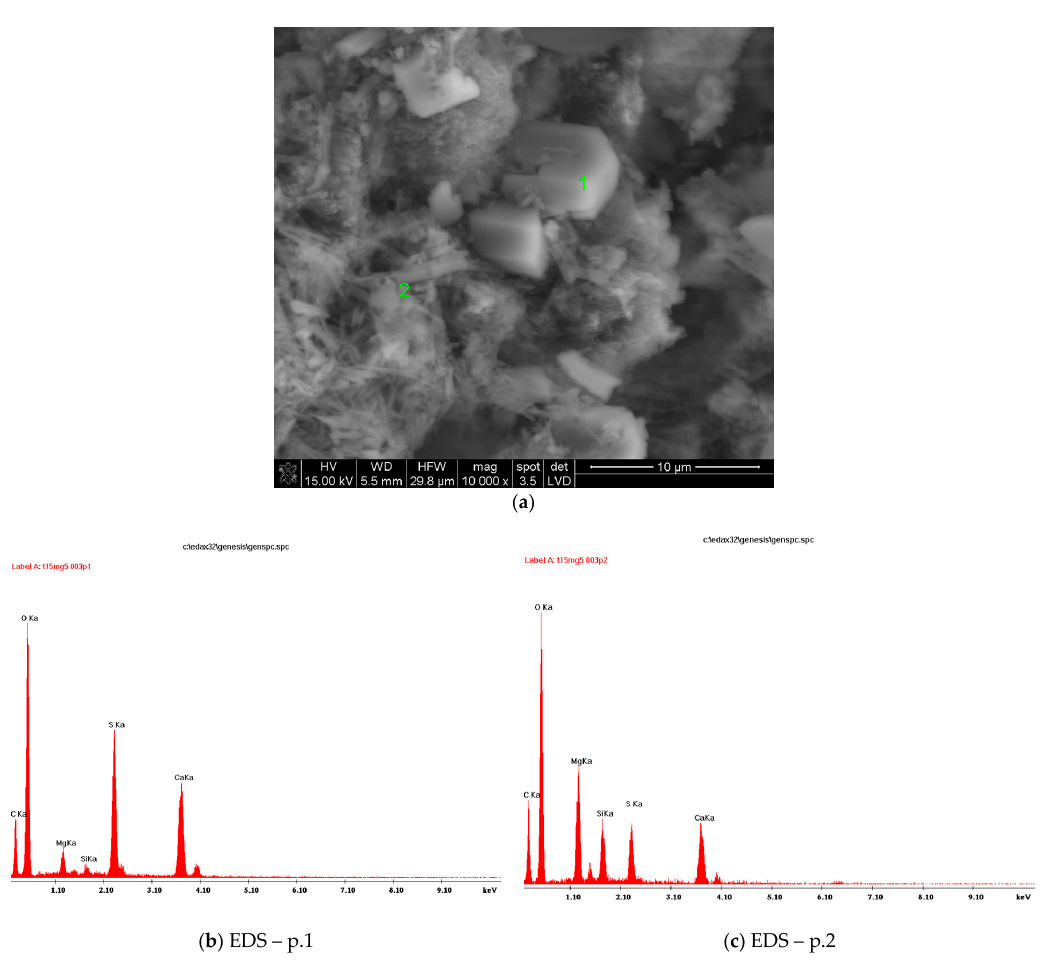
Figure 5. ( a ) SEM observation of the mortar sample made of binder 85%–CEM I 32,5R + 15%–FBC FA BC, stored in MgSO 4 solution (5 °C temperature, 360 days, ×10,000 magnification). The microscopic observation of the spaces occupied by corrosion products indicates gypsum crystals in the observed sample (p. 1) (EDS – ( b )) as well as needle form closed to thaumasite (p. 2) (EDS – ( c )). Attention should be taken to the highest content of the magnesium in the corroded binder mass.